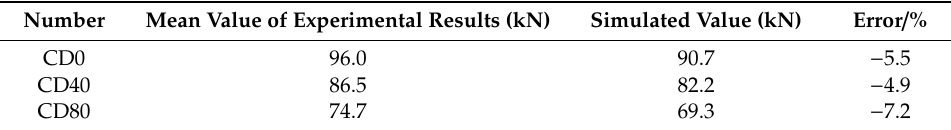
Table 9. Fracture loads of various honeycomb